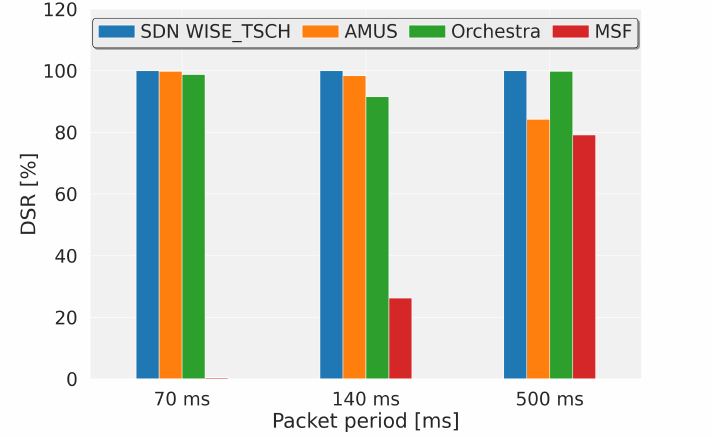
Figure 7. Deadline Satisfaction ratio for each